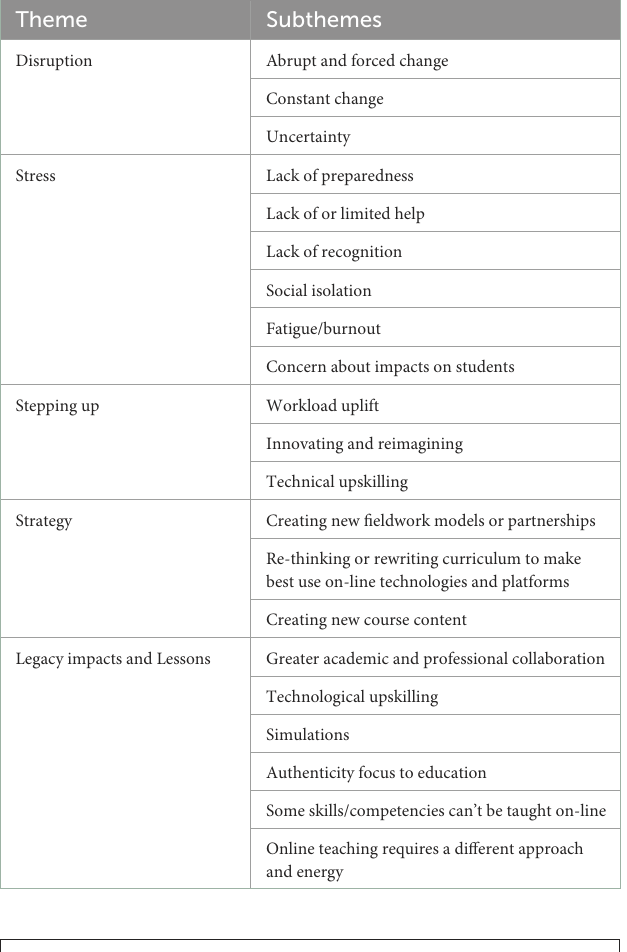
TABLE 3 Major themes and sub-themes.